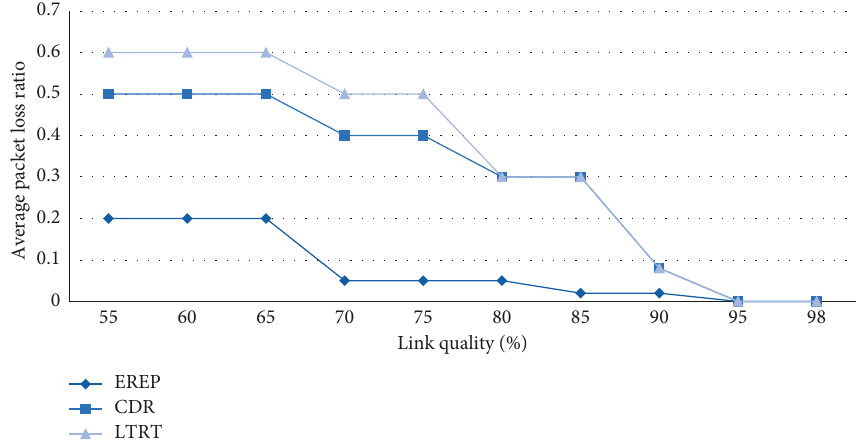
Figure 4: Link quality vs. packet loss ratio at different data generation rates.